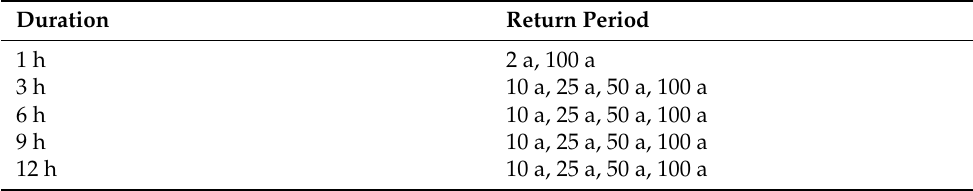
Table 1. Selected statistical precipitation events according to protection level of land use classes ([22], modified).